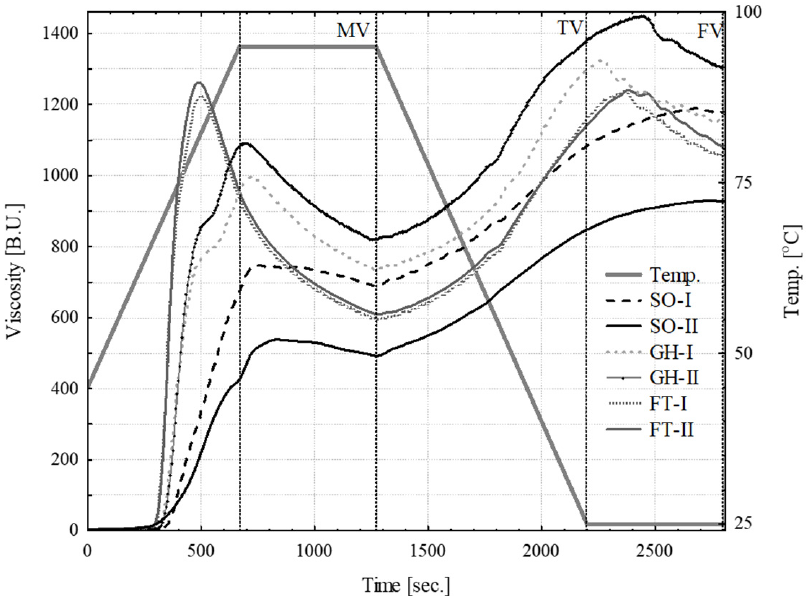
Figure 1. Pasting characteristics of the investigated potato starches (FT—foil tunnel; SO—soil; PT—pasting temperature; MV—minimum viscosity; TV—viscosity at 25 ° C; FV—final viscosity)